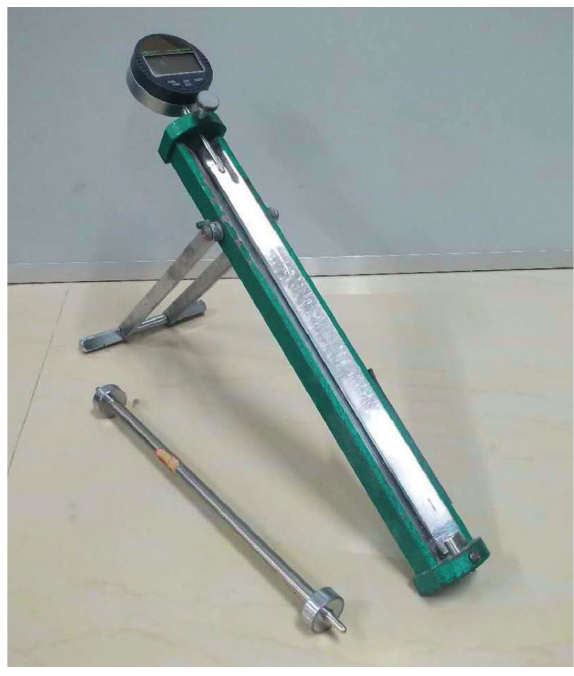
Figure 1: Length comparator.